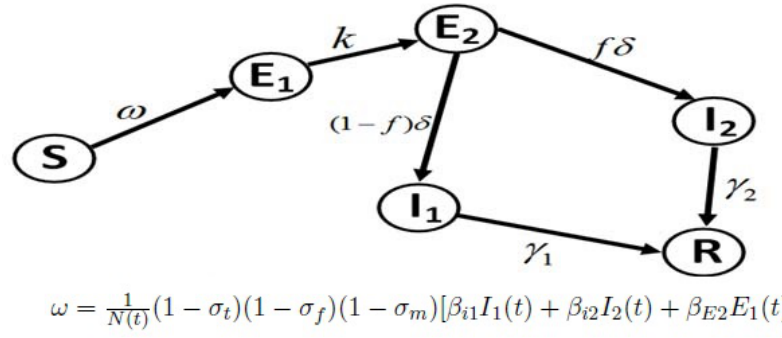
Figure 2. The flow diagram of transmission network for COVID-19 infection in Oyo state,